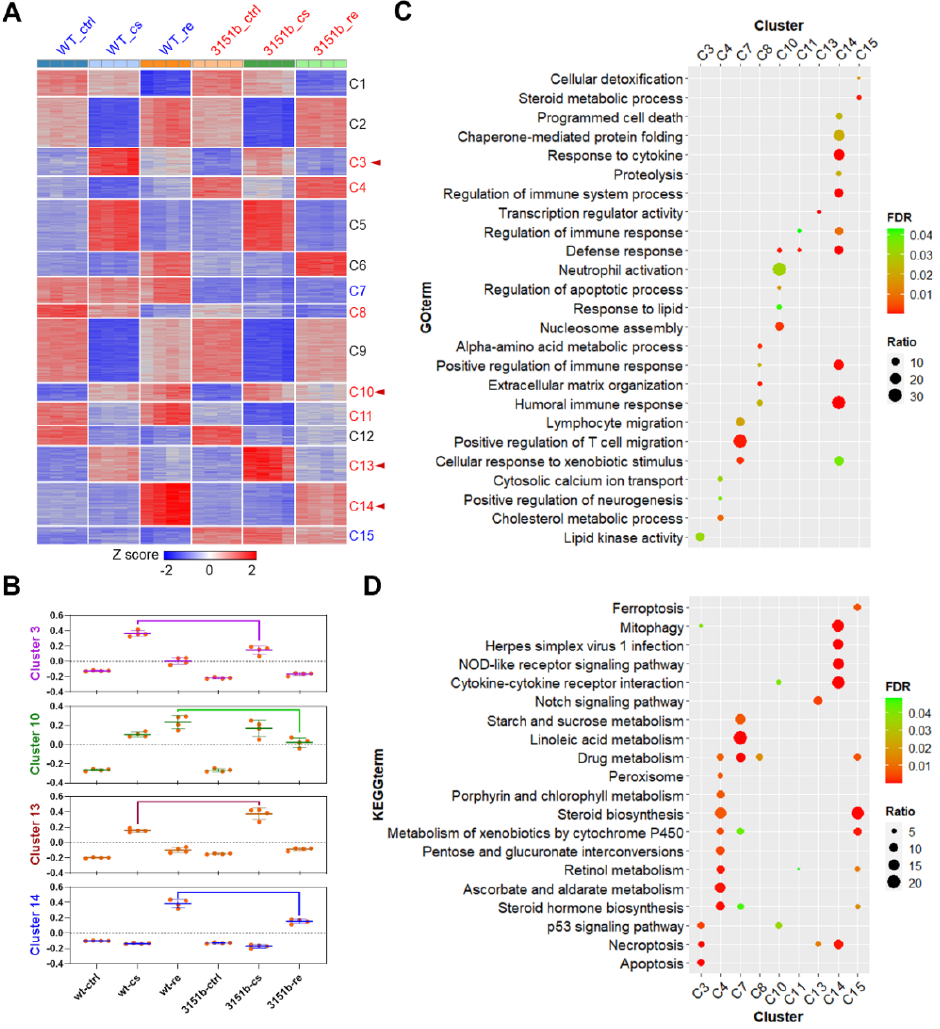
Figure 8. Biological processes and pathways influenced by tmem39b mutation. ( A ) A heatmap demonstrating the expression of DEGs across all the samples. The DEGs are classified into 15 clusters according to their abundance using the k-means clustering algorithm. The cluster names are shown on the right of the heatmap. The clusters regulated by both cold-warm stress and tmem39b mutation are shown in red, while those only influenced by a Tmem39b deficiency are shown in blue. The clusters associated with the functions of Tmem39b in determining cold resistance and damage repair are highlighted with red arrow heads. ( B ) Eigengenes of the gene clusters associated with the functions of Tmem39b. GO terms ( C ) and KEGG pathways ( D ) were enriched for the gene clusters affected by tmem39b mutation. FDR, false discovery rate; ratio, percentage of the identified genes to all the genes associated with a certain